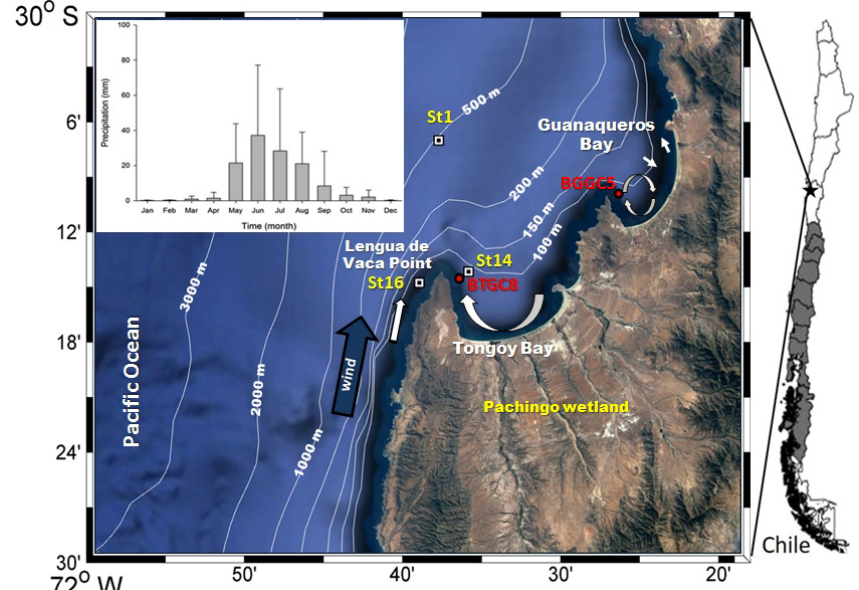
Figure 1. Study area showing the positions of sampling stations. Sediment cores were retrieved from Guanaqueros Bay (BGGC5) and Tongoy Bay (BTGC8) at water depths of 89 and 85m, respectively. Information of dissolved oxygen in the water column at St1 and St16 and that of suspended organic particles collected at St14 sampling sites were gathered in a previous project (INNOVA 07CN13 IXM-150). Monthly precipitation in millimeters (bars; mean ± SD; Montecinos et al., 2016). Schematic representation of the circulation in the bays (white arrows) and wind direction (blue arrow) is indicated, as obtained from Valle-Levinson and Moraga-Opazo (2006) and Moraga-Opazo et al. (2011).